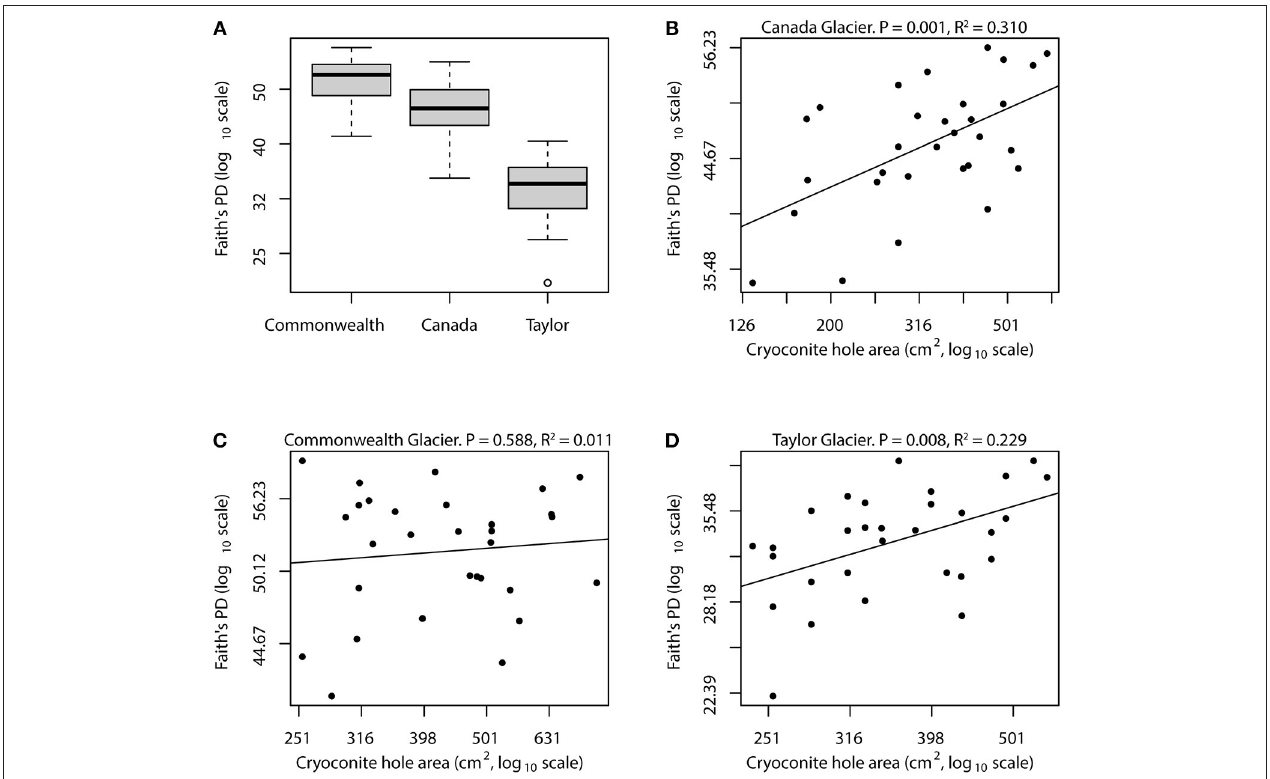
FIGURE 2 | Relationships between island size and bacterial diversity for Taylor Valley cryoconite holes. Mean bacterial phylogenetic diversity is highest on Commonwealth glacier, followed by Canada and Taylor glaciers (A) . Each of the within-glacier mean diversities was significantly different than the other two (Tukey’s HSD, all P < 0.02). Canada and Taylor glaciers showed strong relationships between island size and bacterial diversity, with linear regression models explaining roughly 23 and 30% of diversity variance on log-log scales (B,D) . However, the relationship on Commonwealth Glacier was not statistically significant (C) , possibly because that glacier receives more biological input from nearby streams, causing the island size relationship to be confounded by high immigration